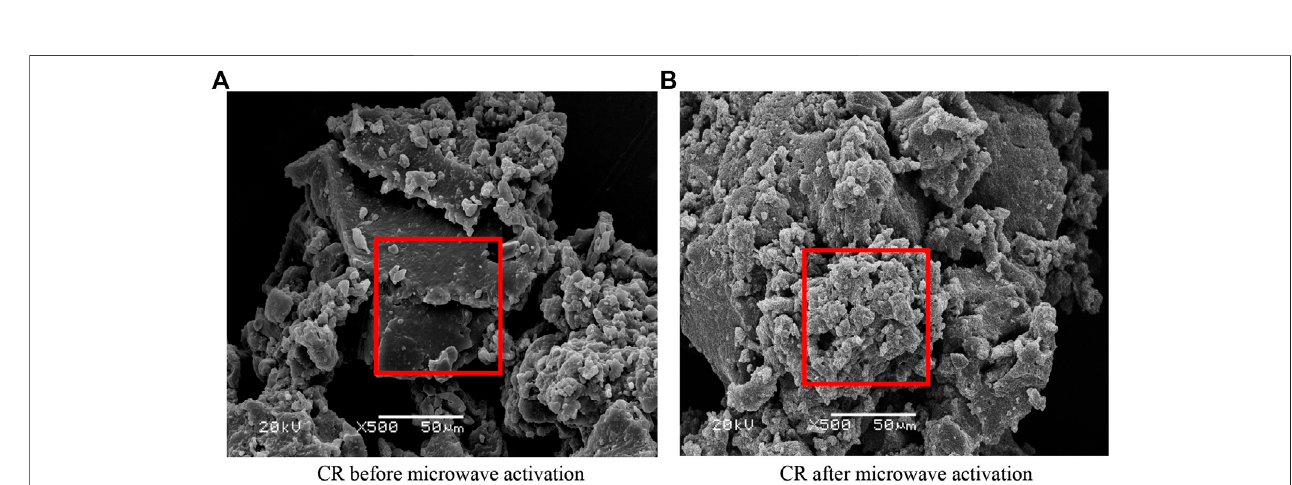
FIGURE 1 | Detailed preparation process of